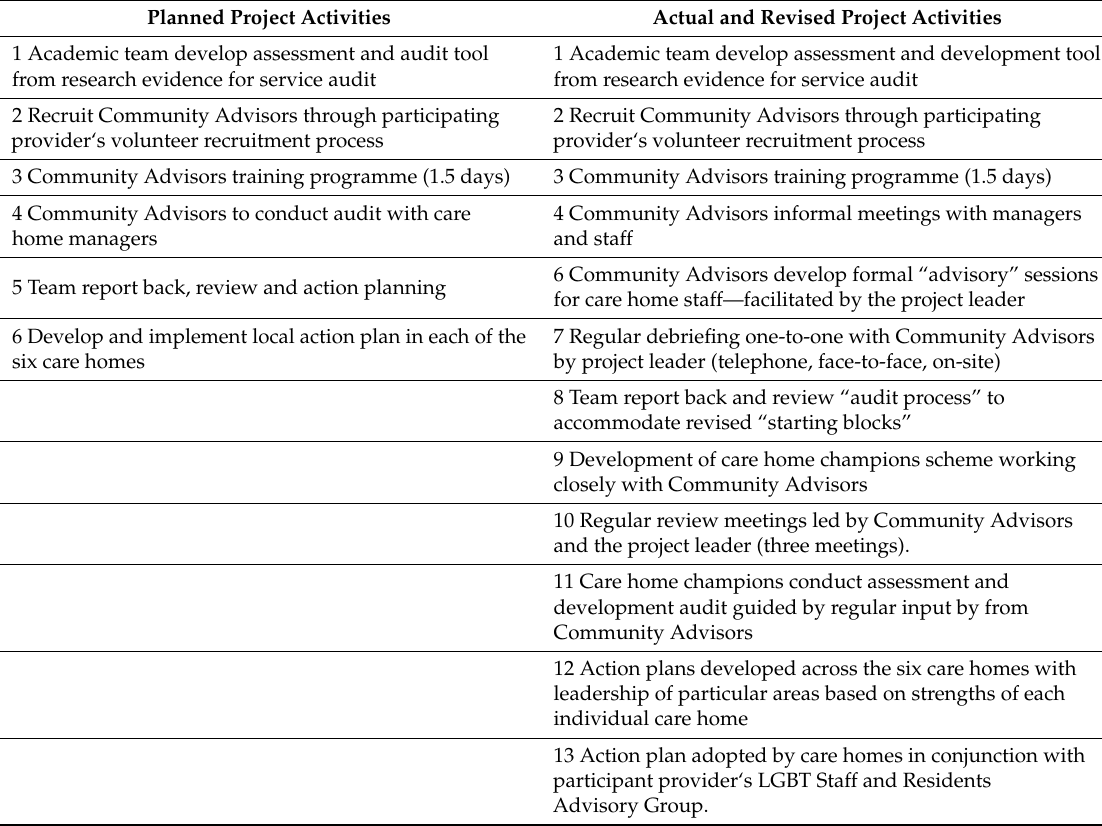
Table 1. Intended Project Activities versus Actual Project Activities led by the Project